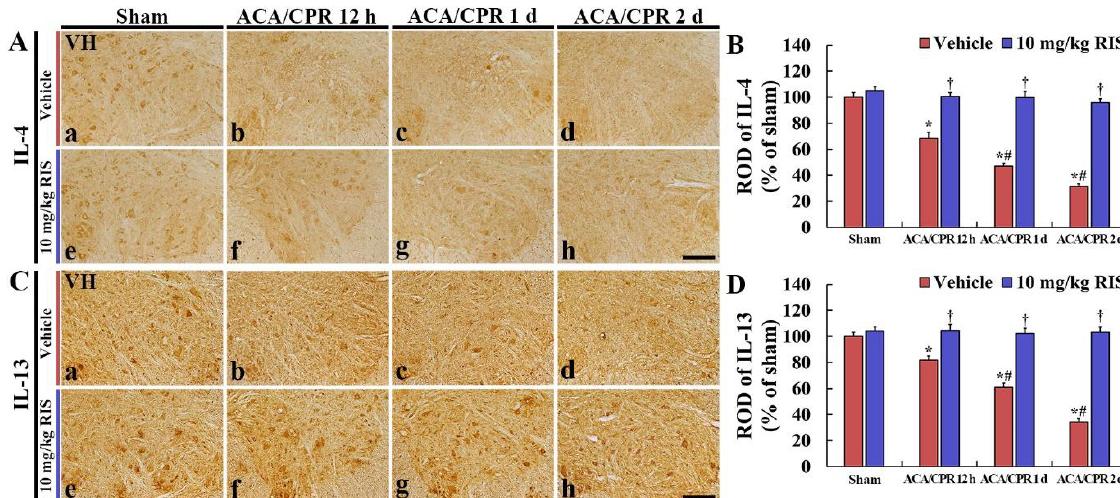
Figure 6. Immunohistochemical staining for IL-4 and IL-13 ( A , C ) Immunohistochemistry for IL-4 ( A ) and IL-13 ( C ) in the ventral horn of the Sham+vehicle ( a ), ACA/CPR+vehicle ( b – d ), Sham+RIS ( e ), and ACA/CPR+RIS ( f – h ) groups at 12 h, 1 day, and 2 days after ACA/CPR. In the ACA/CPR+vehicle group, immunoreactivities of IL-4 and IL-13 are significantly decreased from 12 h after ACA/CPR. However, in the ACA/CPR+RIS group, immunoreactivities of IL-4 and IL-13 are maintained after ACA/CPR. VH, ventral horn. Scale bar = 100 µm. ( A , C ) RODs of IL-4 ( B ) and IL-13 ( D ) immunoreactivity. The bars indicate the means ± SEM ( n = 7; * p < 0.05 vs. Sham+vehicle group; † p < 0.05 vs. ACA/CPR+vehicle group; # p < 0.05 vs. Pre-time point of the corresponding group).